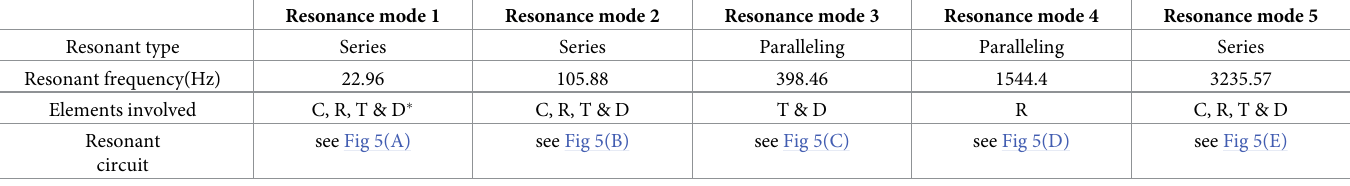
Table 3. Resonance modes of the CVT with a resonant